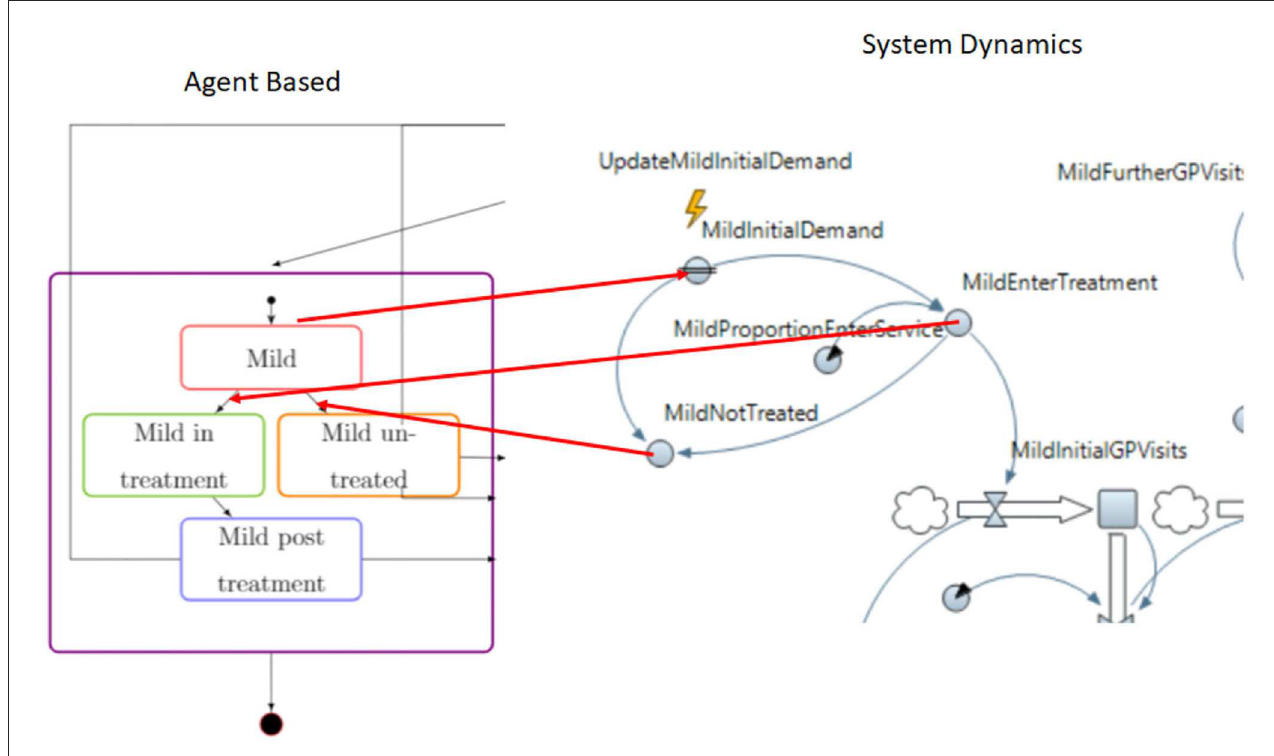
FIGURE3 Combining AB and SD